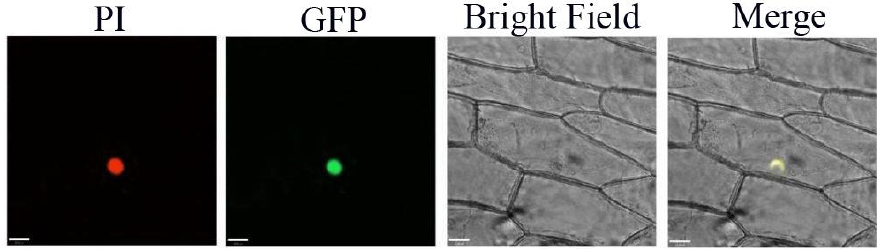
Figure 5. Subcellular location of GFP fusion of PqMYB4. Bars, 33 µm.